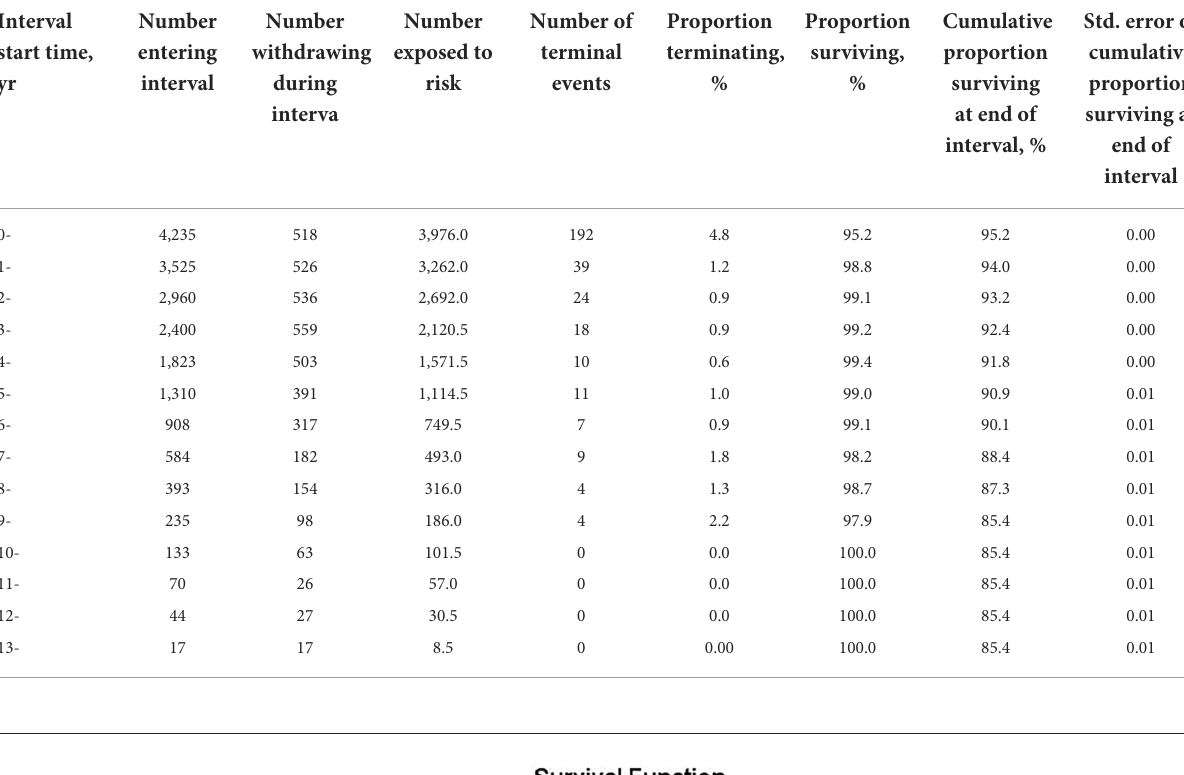
TABLE 1 Survival analysis of PLHIV from to 2005 to 2018 in Nanjing.